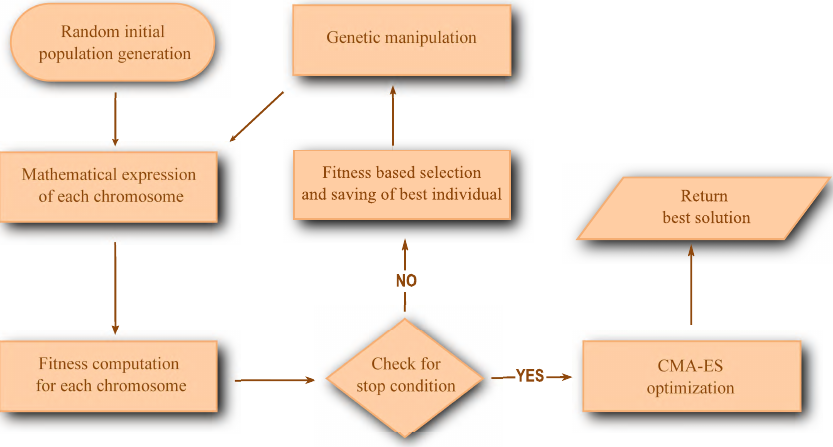
Figure 2. The work flow used in solving symbolic regression problems with GEP. The process of evolving an optimal solution from ob- servations starts with randomly generating a set number of evolution individuals called chromosomes. The chromosomes are composed of genes that are sets of strings encoding expression trees that can be translated into mathematical expressions in the subsequent step. Following the mathematical expression comes the evaluation of each emerging individual (model) against the target variable values and for each one a fitness value is assigned. If the stopping criterion has not been reached (e.g. best fitness possible, highest number of generations allowed, con- vergence) the best individual in terms of fitness is saved and the remaining set of chromosomes are selected for genetic manipulation. When the stop criterion is reached, the parameters of the best chromosome is calibrated against the training data with an optimization approach, the CMA-ES, and the best solution is